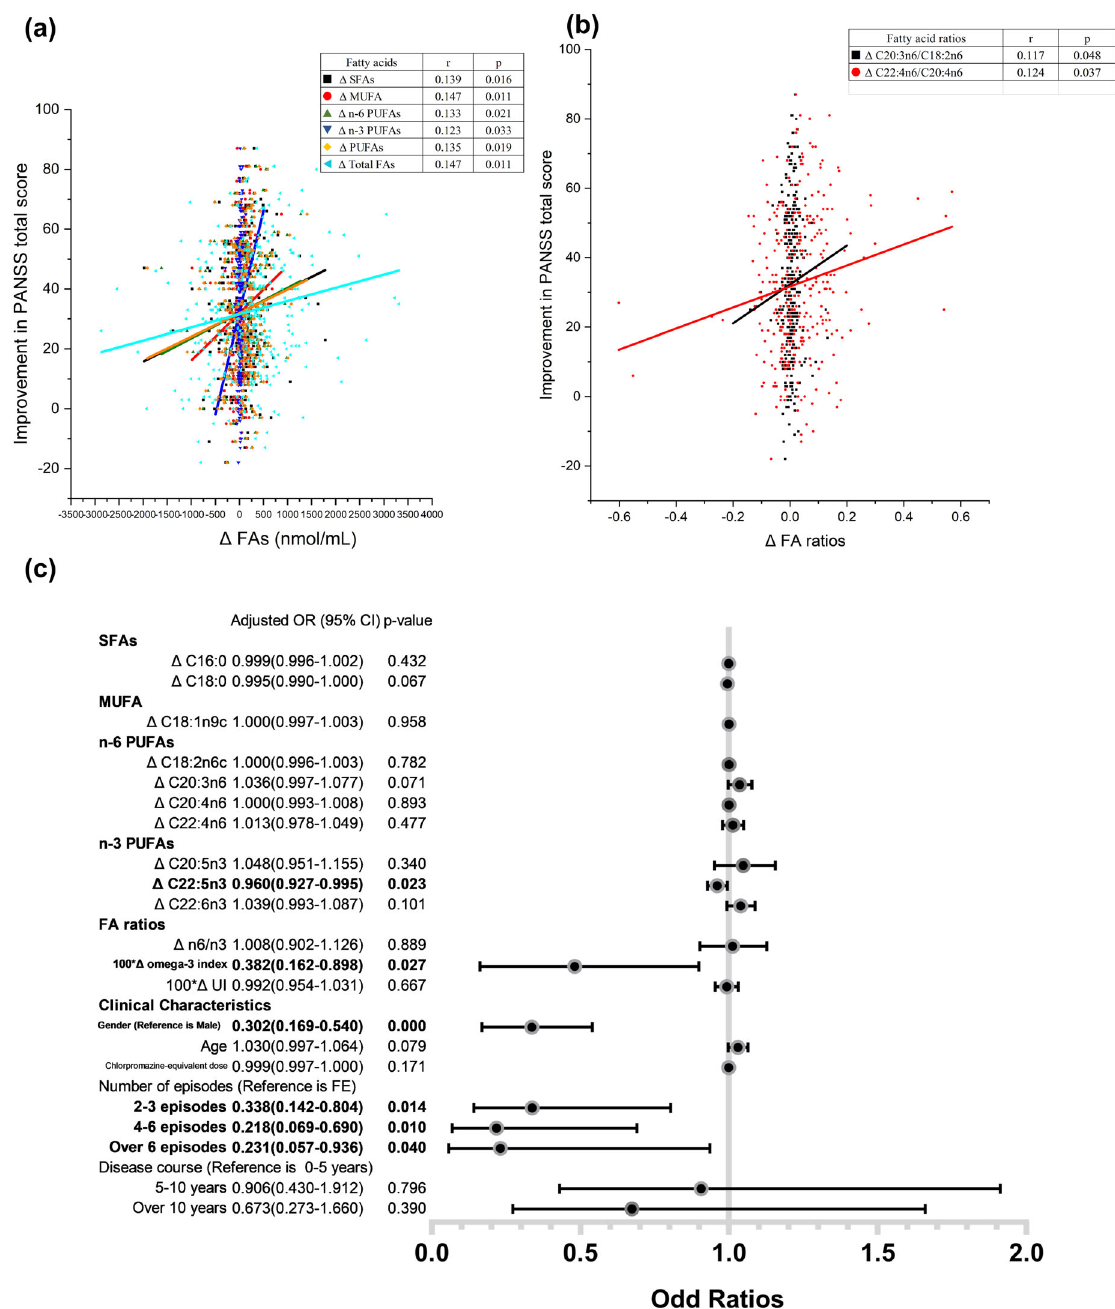
Fig. 4 Partial correlation and logistic regression analyses in all the patients with schizophrenia after antipsychotic treatment. a Signi fi cant correlations between fatty acid level changes and PANSS total score improvement. b Signi fi cant correlations between fatty acid ratio changes and PANSS total score improvement. c Forest plot of logistic regression of treatment response and fatty acid level changes. Gender, age, chlorpromazine-equivalent dose, number of episodes, and disease course are added to the regression model to control the in fl uence of these confounding factors on antipsychotic responses. Partial Spearman ’ s rank correlation and binary logistic regression were (eg. fi rst episode or multi-episode patients). Nonetheless, the abnormalities of fatty acids were reversed signi fi cantly by four weeks of atypical antipsychotic treatment. In a clinical study of patients with chronic schizophrenia, concentrations of membrane fatty acids are not changed after antipsychotic treatment except for DHA with a slight increase 29 . We assume that relapse could account for the inconsistency. Subgroup analysis was performed to explore the effect of relapse on erythrocyte membrane fatty